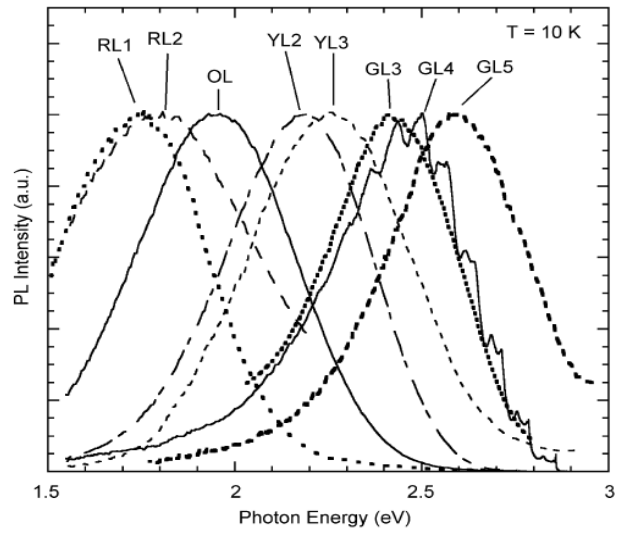
Figure 8. Selected PL bands observed at 10 K in ZnO. Intensity is normalized at band maxima. Reprinted from Ref. [66] with permission.